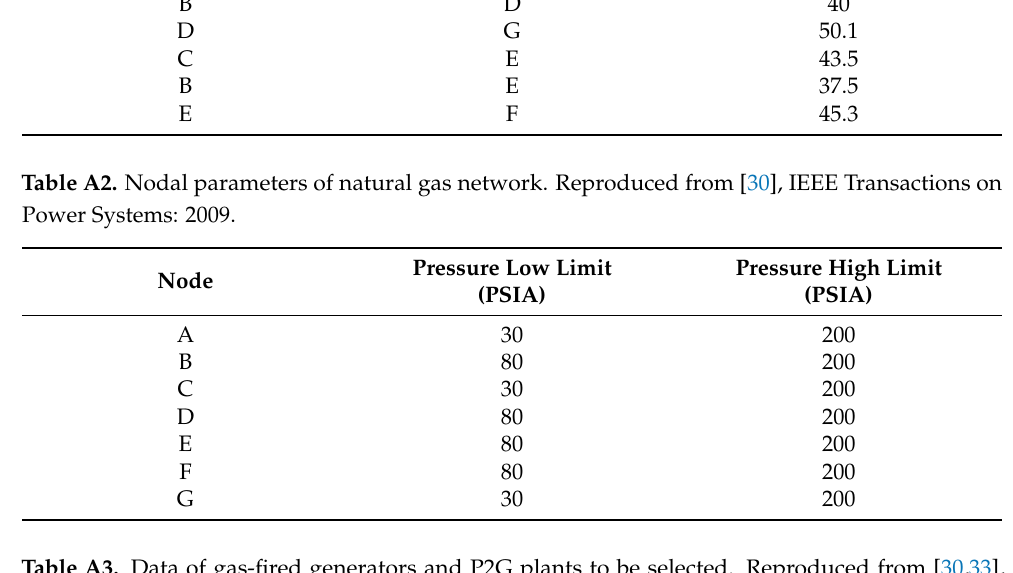
Table A3. Data of gas-fired generators and P2G plants to be selected. Reproduced from [30,33],